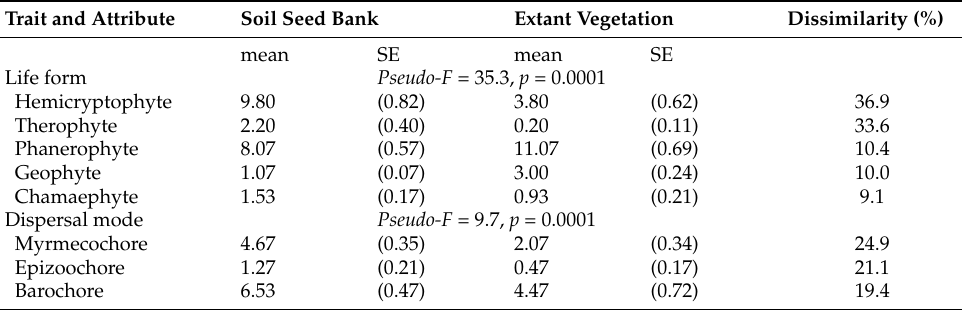
Table 3. Mean number of species per site (across all forest types) with each attribute in the soil seed bank and extant vegetation and the mean contribution to dissimilarity between vegetation pools as determined by SIMPER tests (following PERMANOVA, Pseudo-F and p values shown). Attributes are ordered according to their contribution to